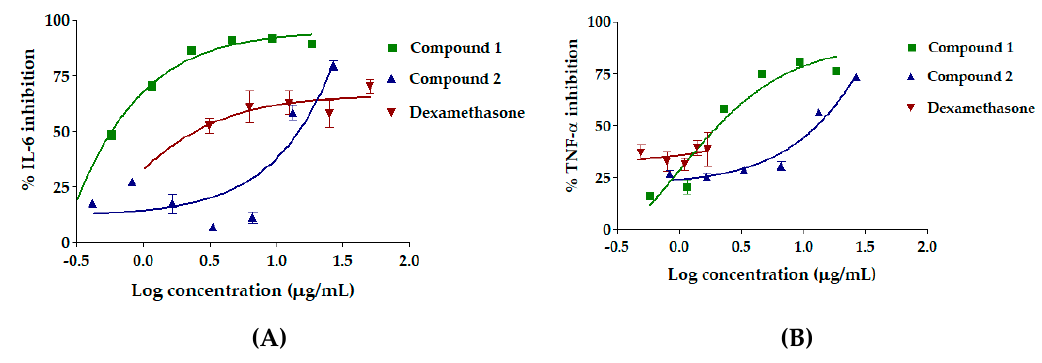
Figure 6. Dose response curve of dexamethasone, compound 1 , and compound 2 on ( A ) IL-6 and ( B ) TNF- α . Each curve represents the mean ± SD of three independent experiments performed in triplicate.